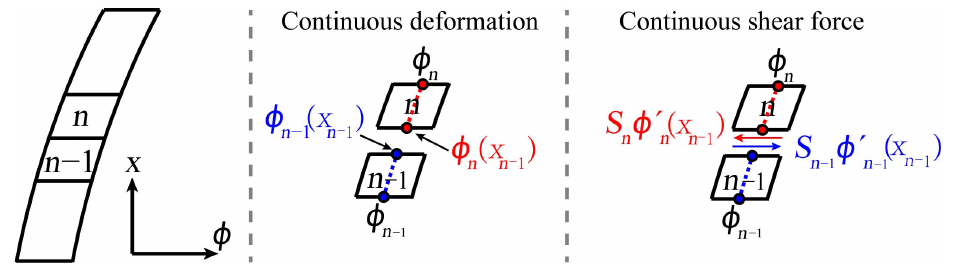
tion matrix for boundary conditions can be established as Equation (11). Figure 2. Illustration of the boundary conditions. Figure 2. Illustration of the boundary